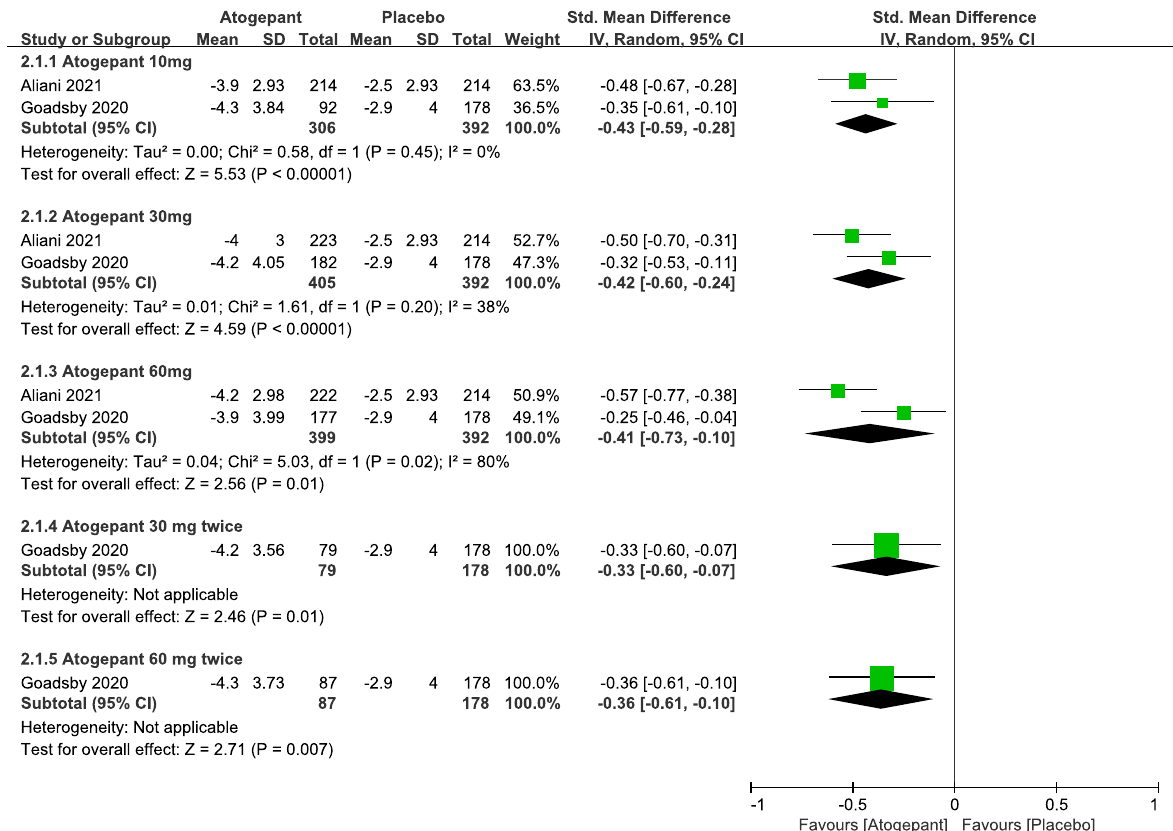
Fig. 3 The pooled SMD of monthly headache days in different doses compared with placebo. The green square indicates the estimated SMD for each RCT. The size of green square indicates the estimated weight of each RCT, and the extending lines indicate the estimated 95% CI of SMD for each RCT. The black diamond indicates the estimated SMD (95% CI) for all patients together. CI, confidence interval; RCT, randomized controlled trial; SMD, standard mean